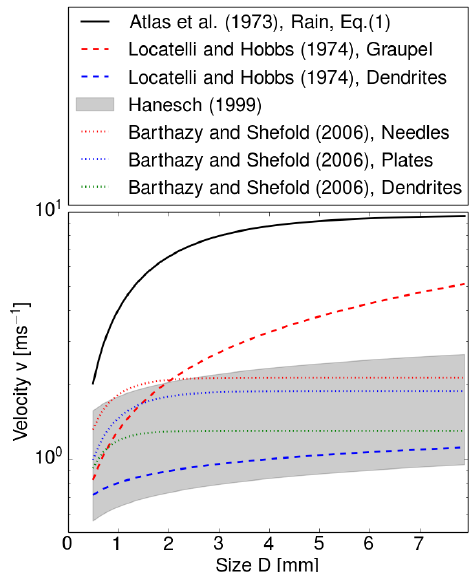
Figure 4. Size–velocity relationships for different types of hydrom- eteors as reported in literature. The term size means diameter in case of rain; in case of snow it means height or maximum dimension.